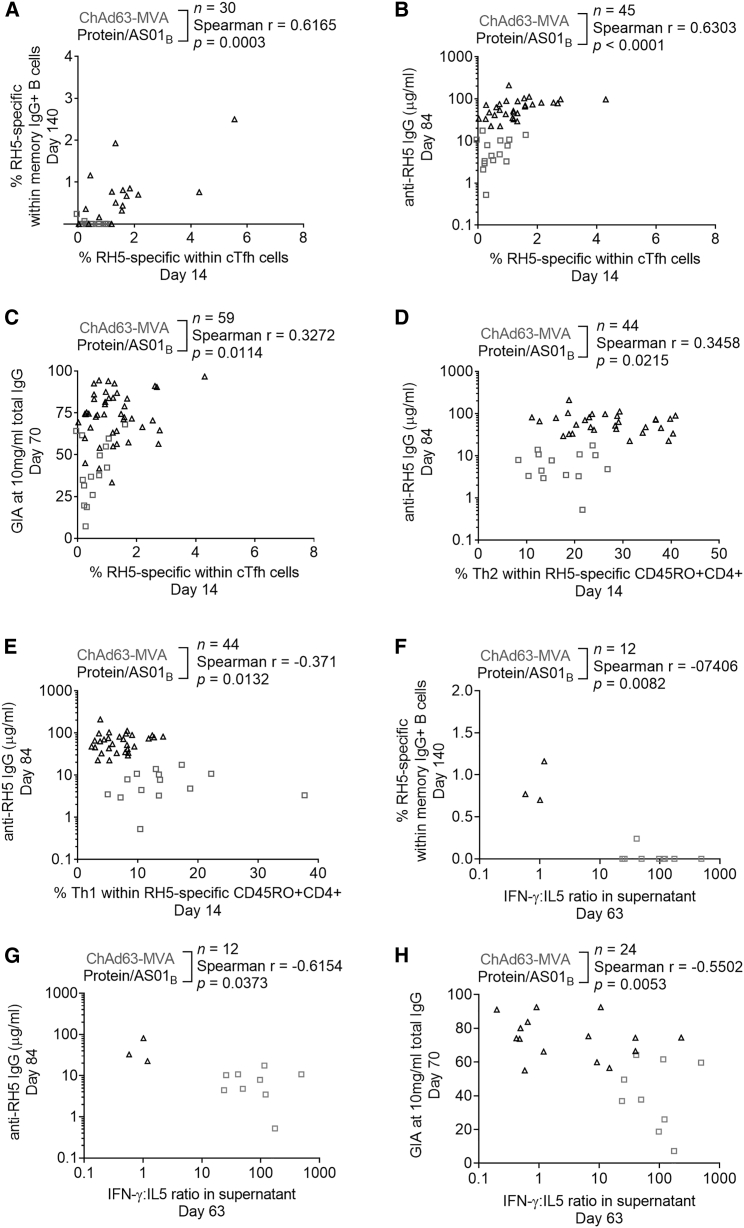
cTfh cell responses and parameters of Th1:Th2 skew correlate with key markers of humoral immunogenicity(A–C) Spearman correlation analyses were performed to interrogate the relationships between the frequency of PfRH5-specific cTfh cells at day 14 and the frequency of IgG+ mBCs that were PfRH5 specific at day 140 (A), the serum anti-PfRH5 IgG concentration at day 84 (B), and the purified IgG GIA at 10 mg/mL at day 70 (C).(D–H) Spearman correlation analyses were also performed between the frequency of Th2 (CXCR3−CCR6−) (D) or Th1 (CXCR3+CCR6−) (E) cells within PfRH5-specific CD45RO+CD4+ T cells at day 14 and serum anti-PfRH5 IgG concentration at day 84, as well as between the IFN-γ:IL-5 ratio in day 63 supernatants and the frequency of IgG+ mBCs that were PfRH5 specific at day 140 (F), serum anti-PfRH5 IgG concentration at day 84 (G), and the purified IgG GIA at 10 mg/mL at day 70 (H).Sample sizes, Spearman r, and p values annotated on the graphs refer to analyses of pooled samples from both vaccine platforms. In all of the panels, each point represents a vaccinee.